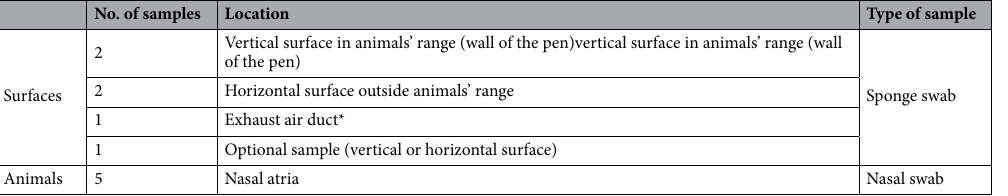
Table 3. Number of samples and sampling locations per farm visit. *If